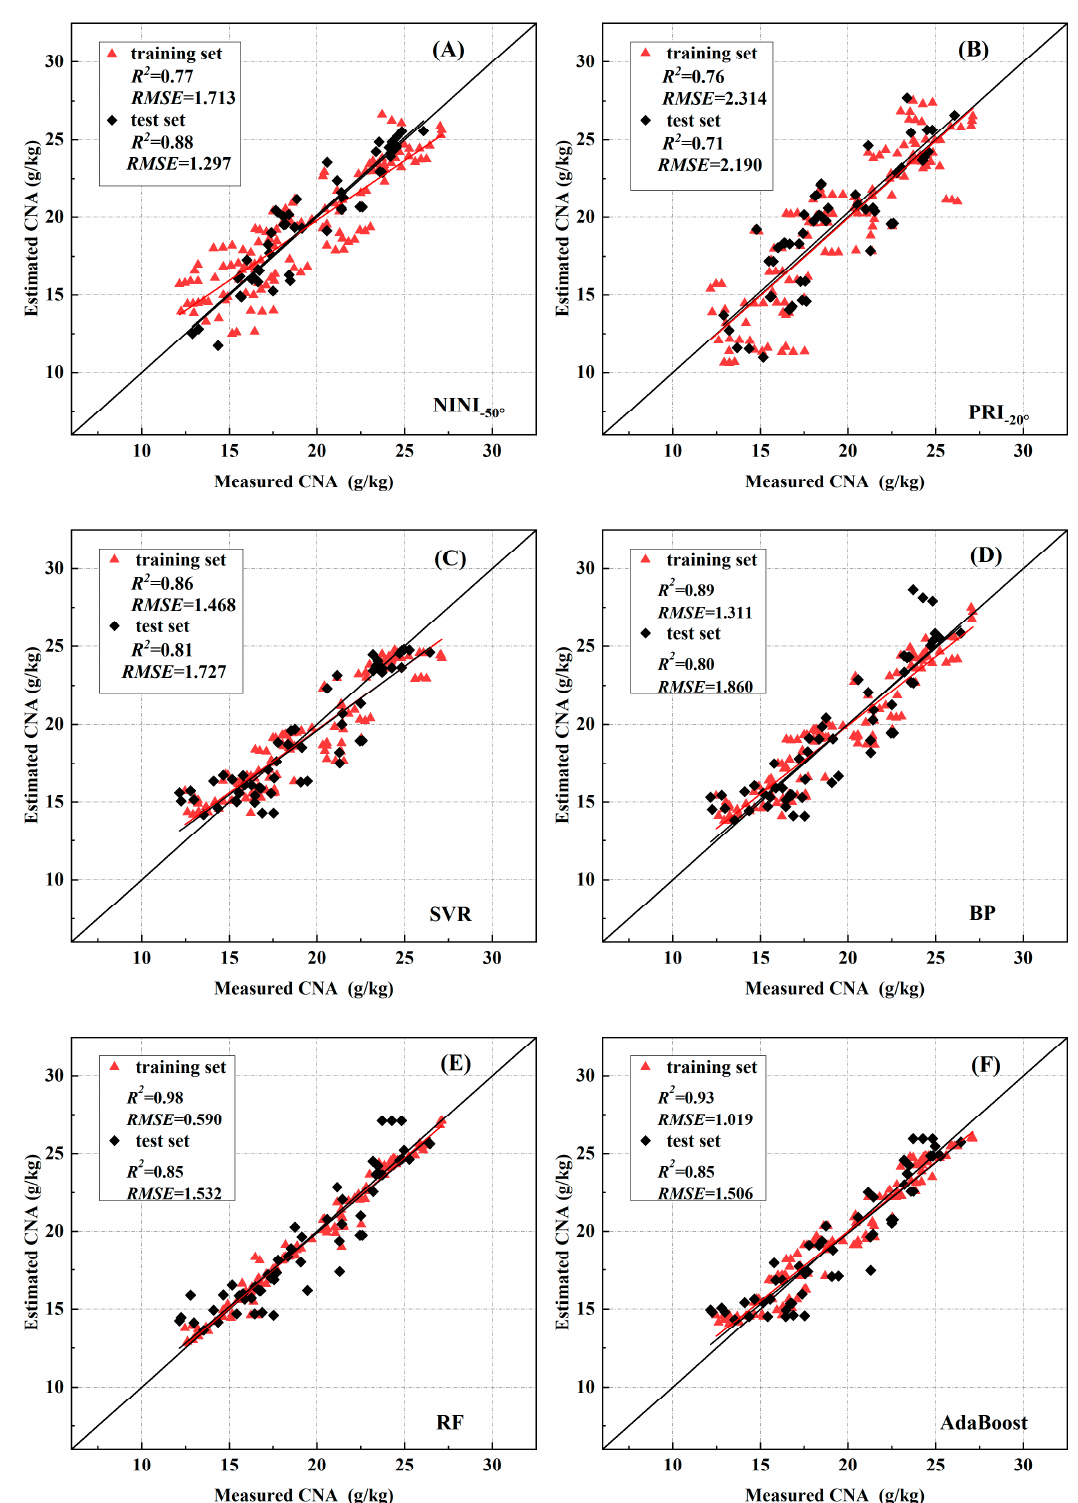
Figure 9. Comparison of predicted and measured values of nitrogen accumulation in cotton canopy based on AINI − 50 ◦ , PRI − 20 ◦ , and their combinations ( n = 180, training set = 126, validation set = 54): ( A ) − 50 ◦ AINI, ( B ) − 20 ◦ PRI, ( C ) SVR Modeling of two spectral indices combination, ( D ) BP Modeling of two spectral indices combination, ( E ) RF Modeling of two spectral indices combination, ( F ) AdaBoost Modeling of two spectral indices combination.